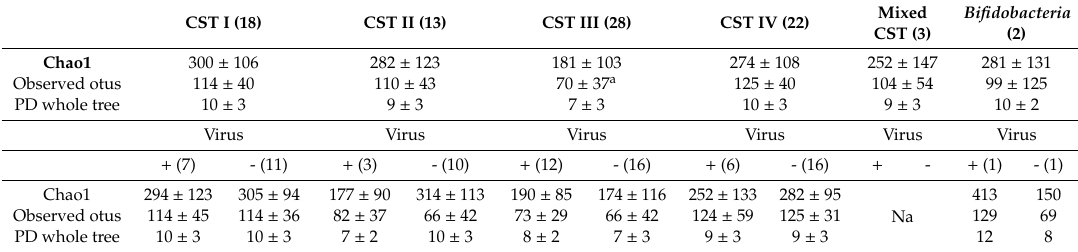
Figure 2. The bacterial di ff erences among CSTs. The figure shows the significantly modulated bacteria among CSTs ( p value < 0.05). Di ff erences were calculated by means of a non-parametric T-test for pairwise comparisons among CSTs (Quantitative Insights Into Microbial Ecology, QIIME, 1.9.1). White bars show significant comparisons. * p < 0.05; ** p < 0.01. Table 1. Comparison of bacterial diversity among CSTs. Bacterial alpha diversity values are given as the mean ± standard deviation at a rarefaction depth of 5000 sequences per sample. Alpha diversity was compared among CSTs and, within each CST, between viral DNA positive and negative samples by means of a non-parametric t-test using the compare_alpha_diversity.py script of QIIME. a = p < 0.05 for CST III vs CST I and for CST III vs CST